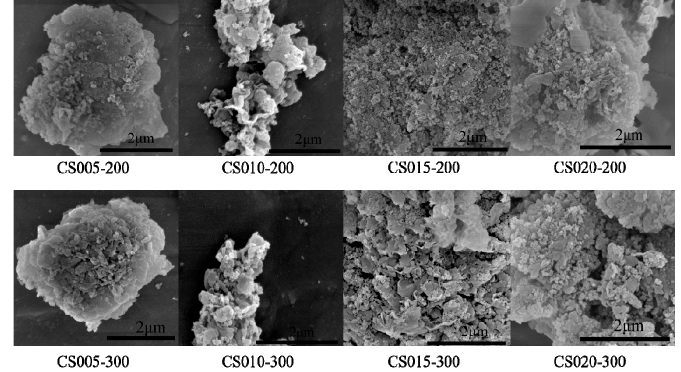
Figure 3. SEM images of CS005-200, CS010-200, CS015-200, CS020-200, CS005-300, CS010-300, CS015- 300, CS020-300.